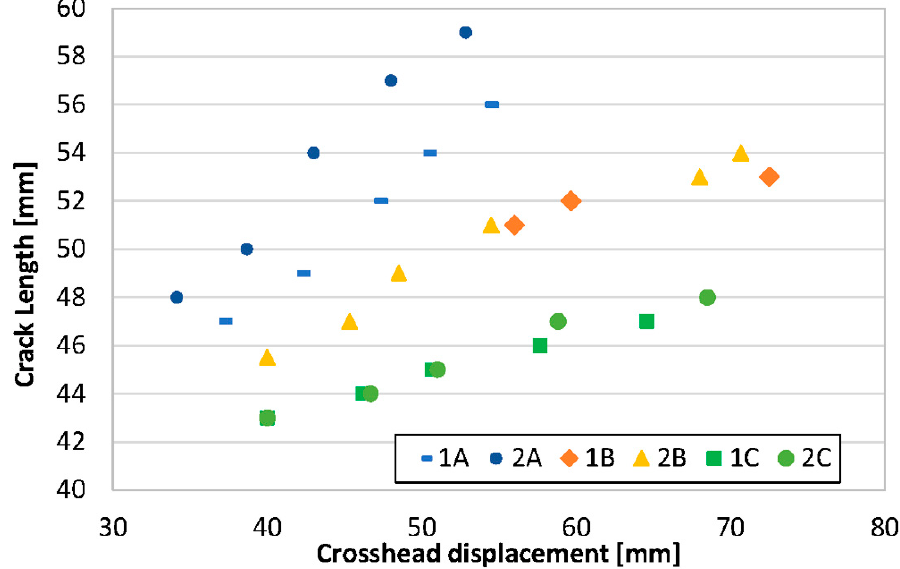
Figure 6. Crack length vs. crosshead displacement.